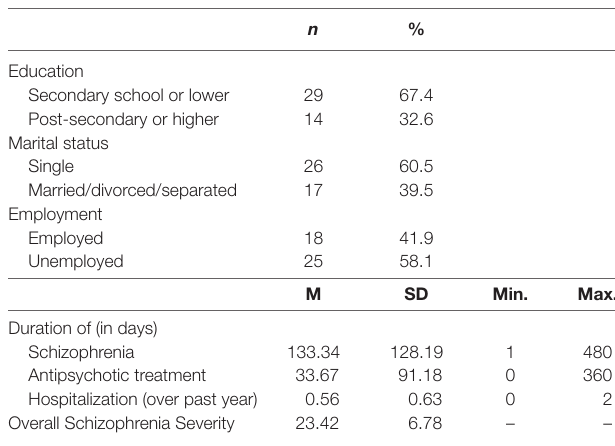
TaBle 1 | Characteristics of the sample ( n =